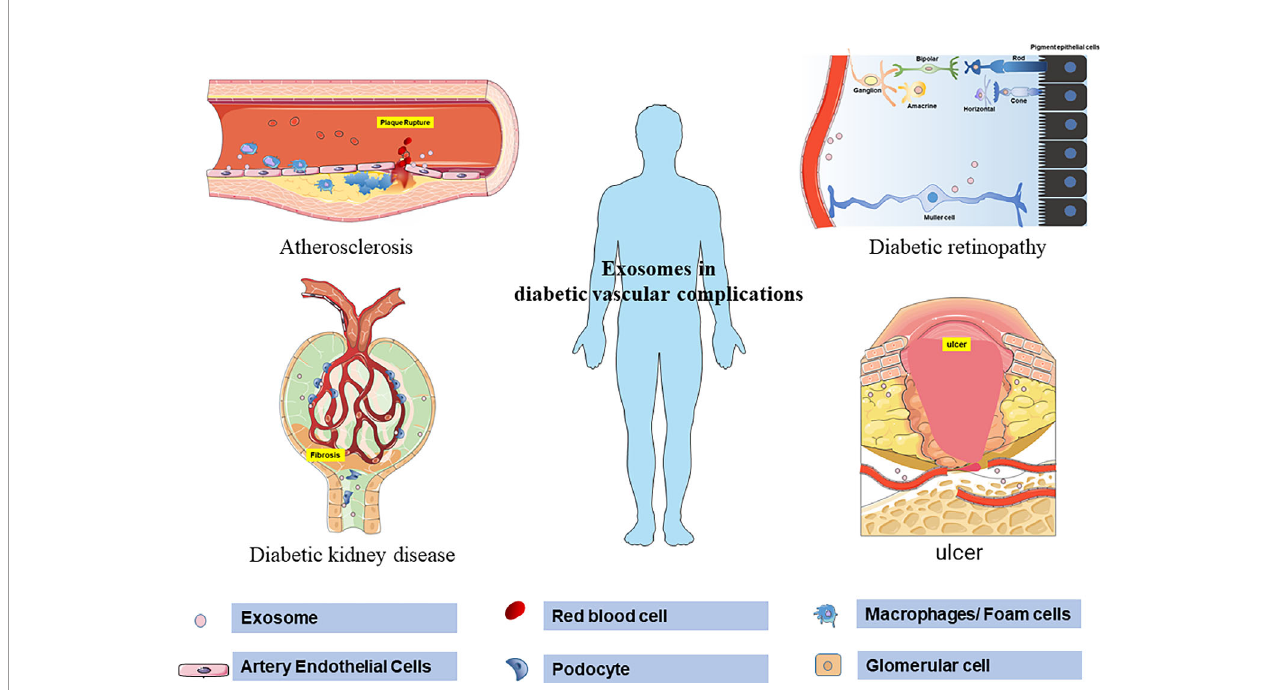
FIGURE 2 | Schematic representation of exosomes regulating the pathological process of diabetic vascular complications. Exosomes mediate atherosclerosis and plaque rupture by regulating the production of no in aortic endothelium, increasing adhesion molecules, in fl ammatory transformation of macrophages, and endothelial proliferation in diabetes. In the retina, exosomes promote angiogenesis, destroy endothelial cells and increase leakage. At the same time, exosomes mediate the apoptosis of Müller cells in the early stage of DR and the proliferation and fi brosis of Müller cells in the late stage of DR. Exosomes carrying proteins and microRNAs mediate podocyte injury, basement membrane thickening, mesangial dilatation, and glomerulosclerosis in diabetic patients. Exosomes derived from stem cells can accelerate wound healing by regulating the proliferation and migration of fi broblasts and vascular endothelial